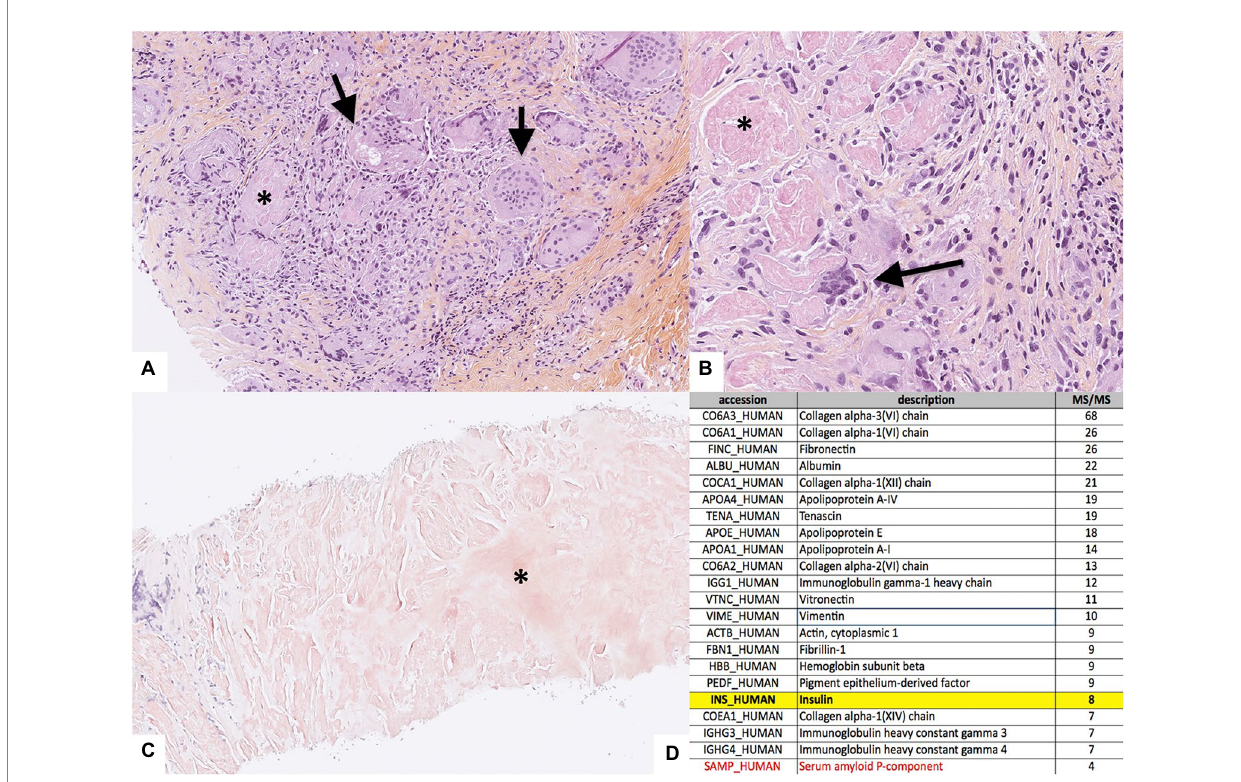
FIGURE 2 Histological analyses of the biopsy of one subcutaneous nodule. (A) HES section at low magnification (x10) evidencing granulomas with giant cells (arrows) phagocytizing the amorphous substance (*), (B) HES section at higher magnification (x40), (C) Section at low magnification (x4) stained with Congo Red evidencing the amyloid deposit (*), and (D) Detailed results of the mass spectrometry evidencing the insulin protein highlighted in yellow, along with the serum amyloid P-component in red (of note, immunoglobulin heavy gamma chains were of polyclonal